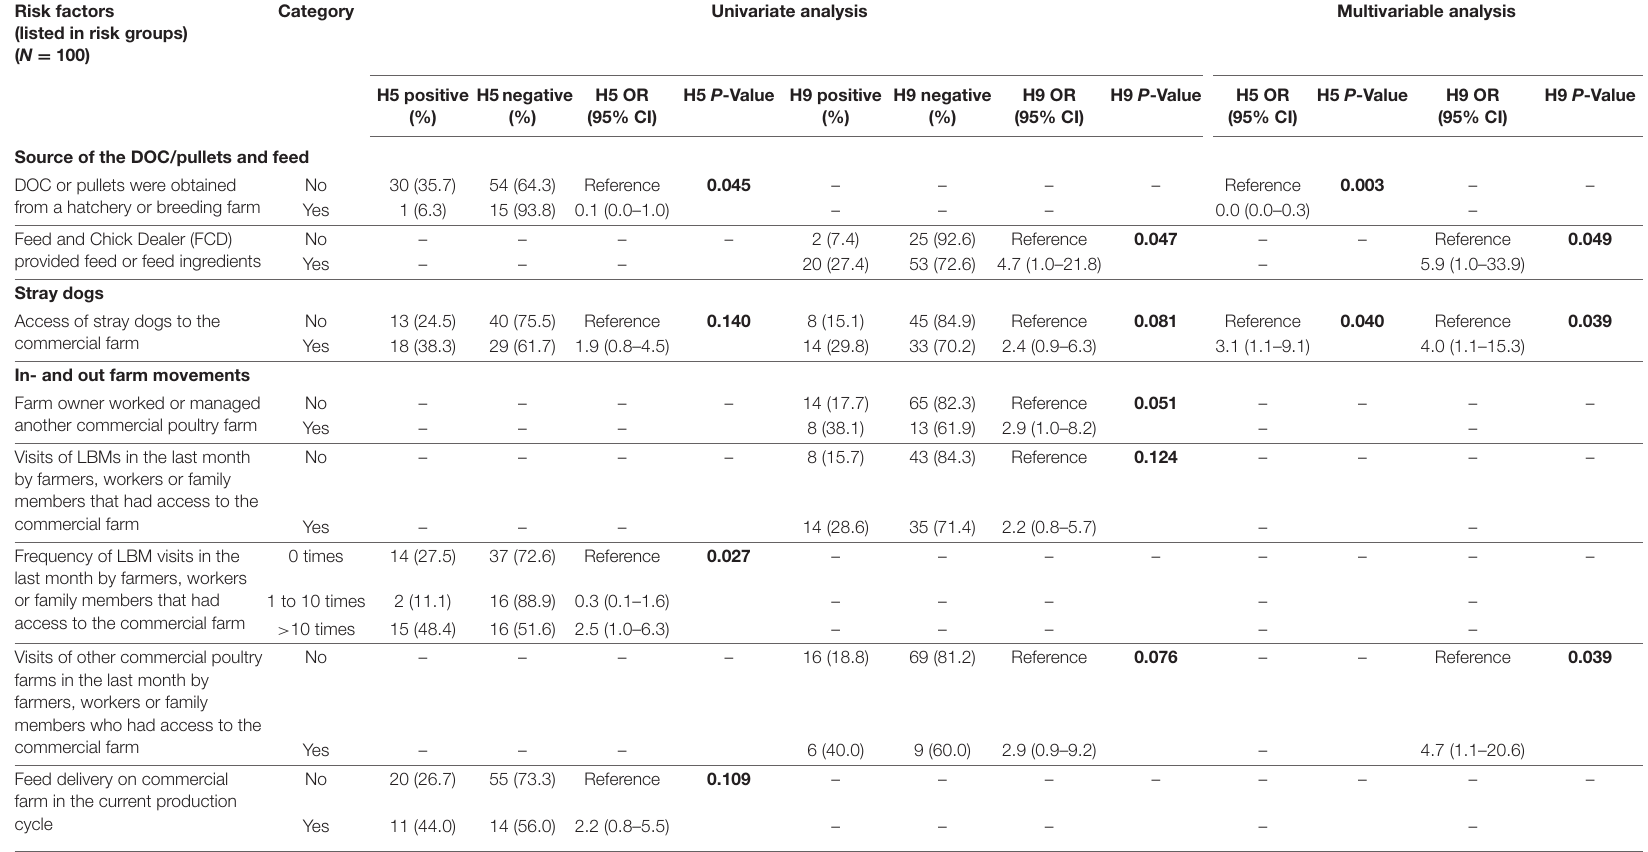
TABLE 2 | Results of the univariate and multivariable analysis for farm-level risk factors associated with H5 and H9 flock–level seroprevalence on layer farms in Bangladesh, 2017. Risk factors (listed in risk